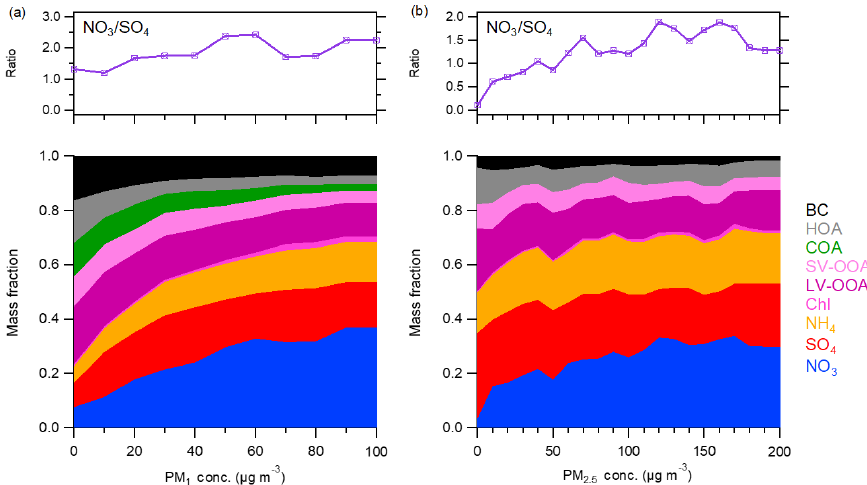
Figure 3. Variations in the mass fraction of aerosol species and nitrate / sulfate mass ratio as a function of total PM 1 mass loadings in (a) Beijing and (b)